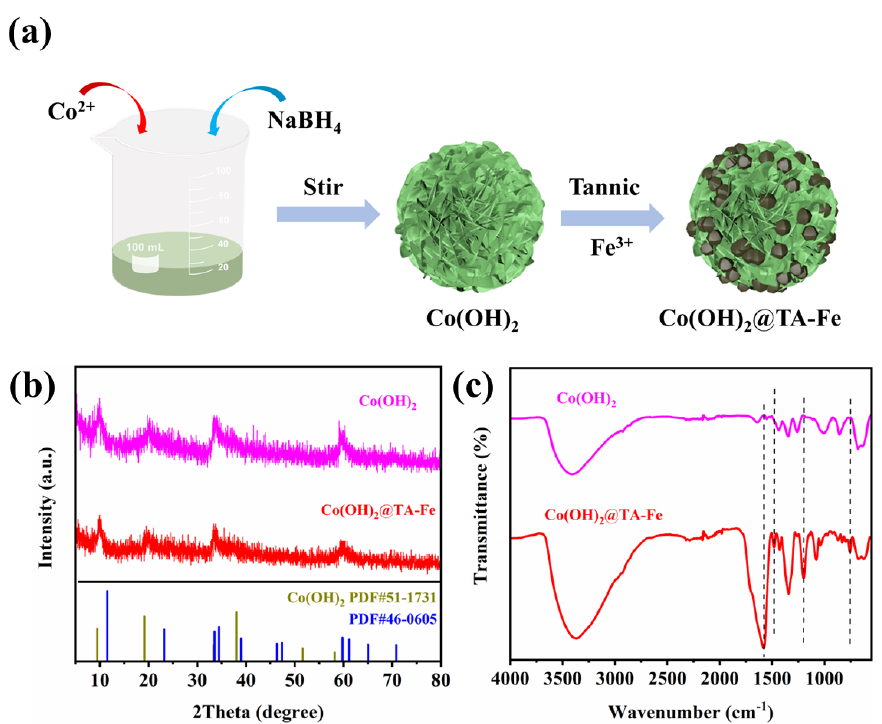
Figure 1. ( a ) Schematic image of the preparation route of Co(OH) 2 @TA − Fe. ( b ) XRD patterns and ( c ) FT − IR spectra of Co(OH) 2 and Co(OH) 2 @TA − Fe.